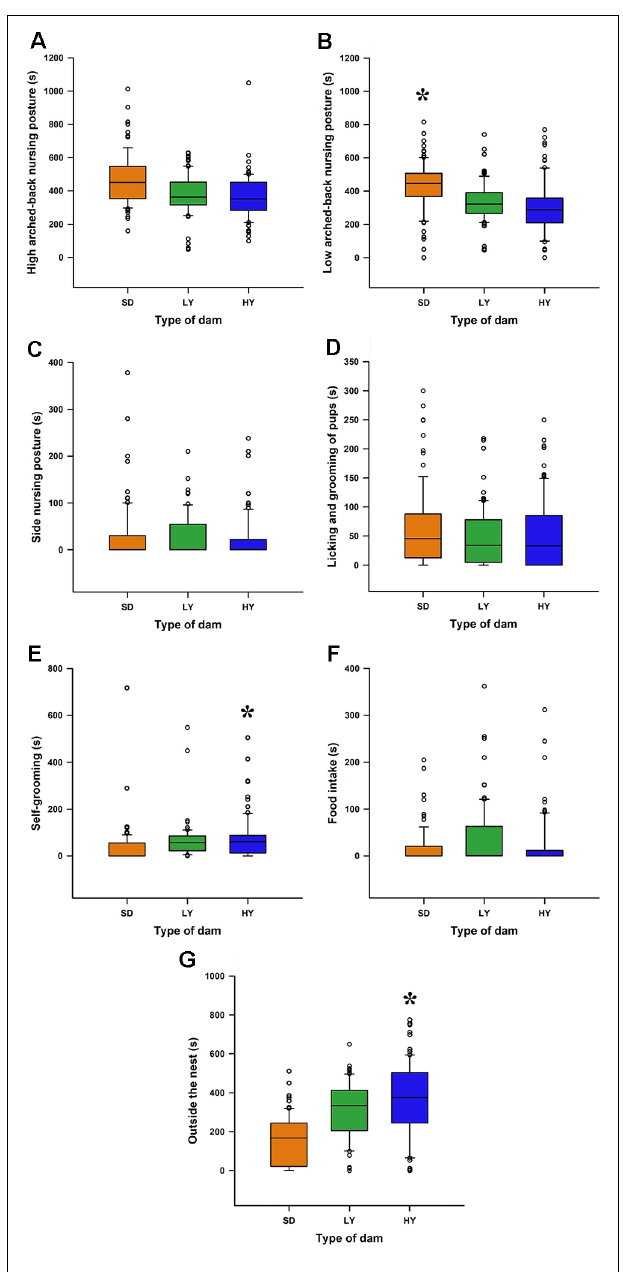
FIGURE 5 | Spontaneous maternal care display in the early lactation period in HY and LY dams or in SD dams. (A) High arched-back nursing posture did not differ between sublines or with respect to SD dams. (B) SD dams had a higher time spent in the low arched-back nursing position with respect to HY and LY dams (* P < 0.05). (C) The time spent in the side-nursing posture was similar between the sublines or in SD dams. (D) The time spent in licking or grooming the pups was similar among HY, LY, or SD dams. (E) The time spent in self-grooming is higher in HY dams with respect to LY or SD dams (* P < 0.05). (F) The time the dams spent on eating pellets was similar in the different group of rats. (G) HY dams spent more time inside the nest with respect to LY or SD dams (* P <